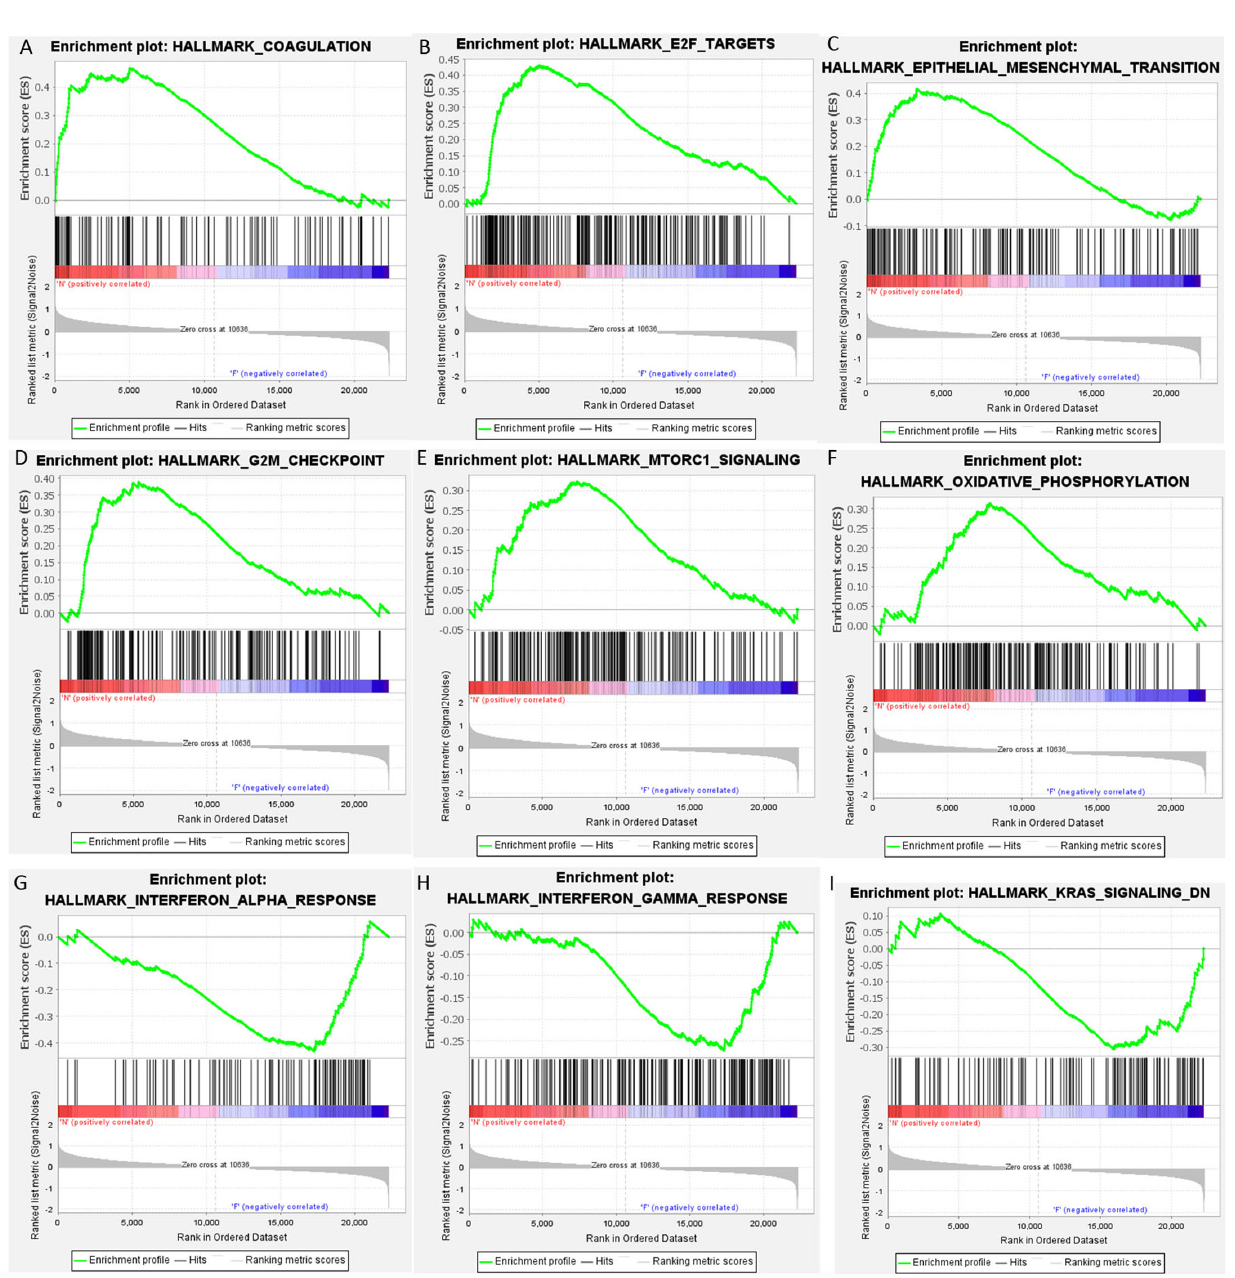
Figure 3. Gene set enrichment analysis illustrated upregulated gene sets in non-recurrent (A–F) and recurrent groups